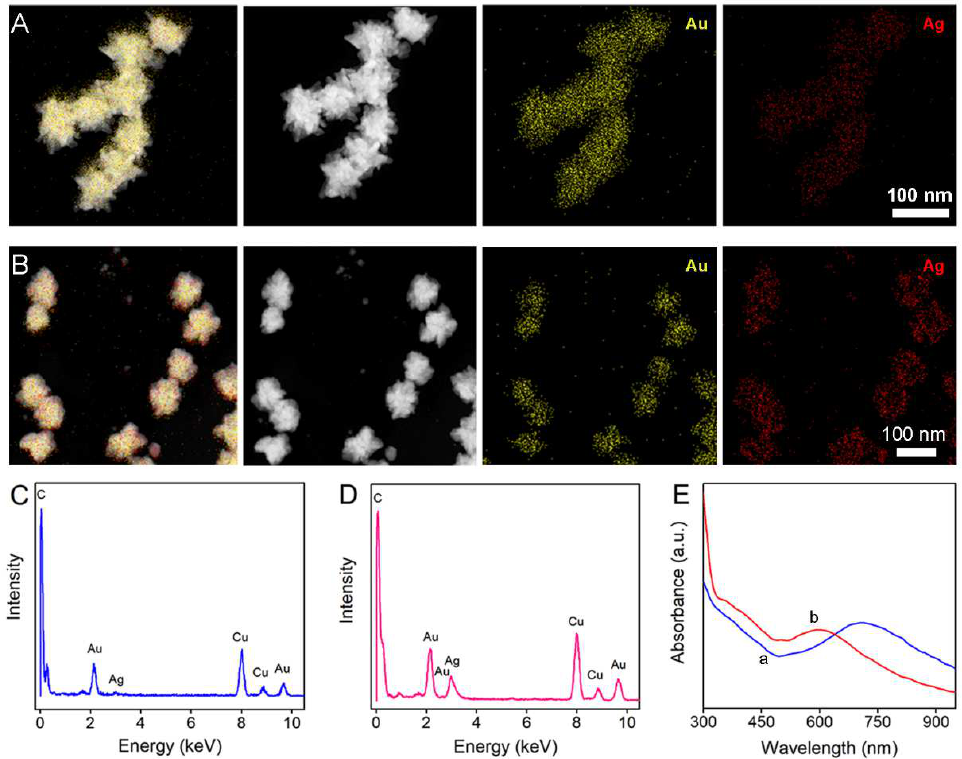
Figure 2. STEM-EDS elemental mapping images of ( A ) 14.0 μM and ( B ) 40.0 μM CC-mediated reduction of Ag + on the Au NSs. EDS spectrum of ( C ) 14.0 μM and ( D ) 40.0 μM CC-mediated reduction of Ag + on the Au NSs. (E) UV-vis absorption spectra of ( a ) 14.0 μM and ( b ) 65.0 μM CC-mediated reduction of Ag + on the Au NSs.